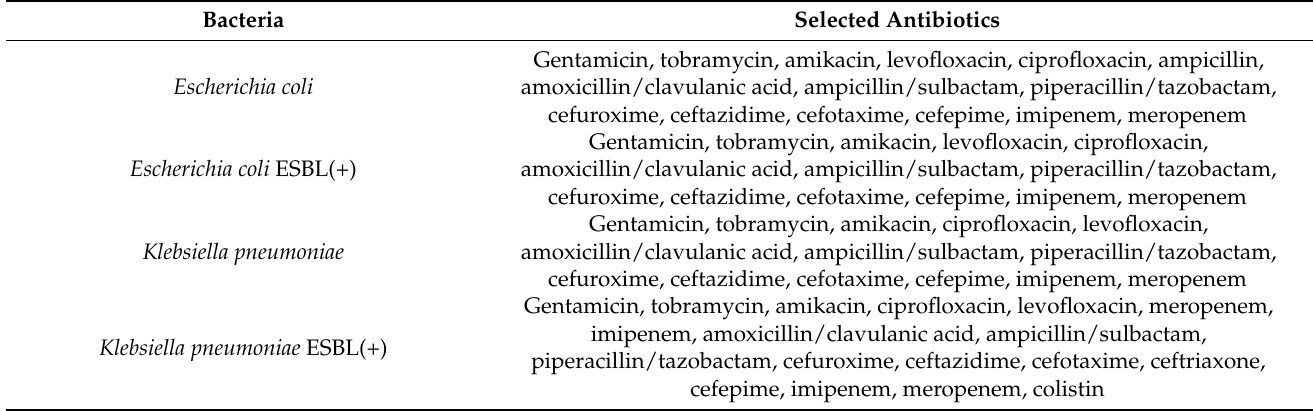
Table 2. Antibiotics to which the susceptibility of the tested strains was